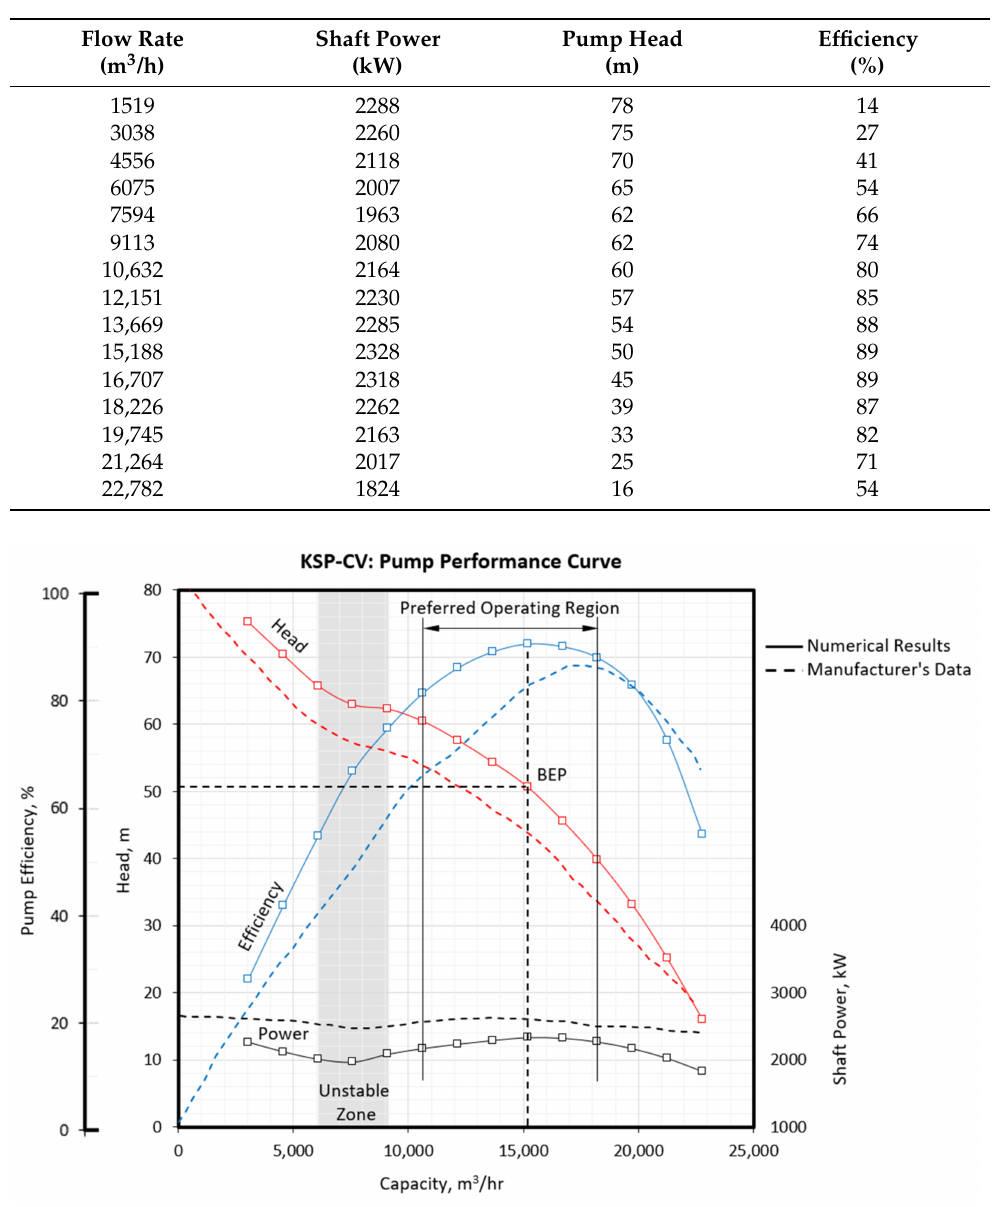
Figure 7. The pump performance curve based on numerical results as compared with the expected performance curve acquired from the manufacturer